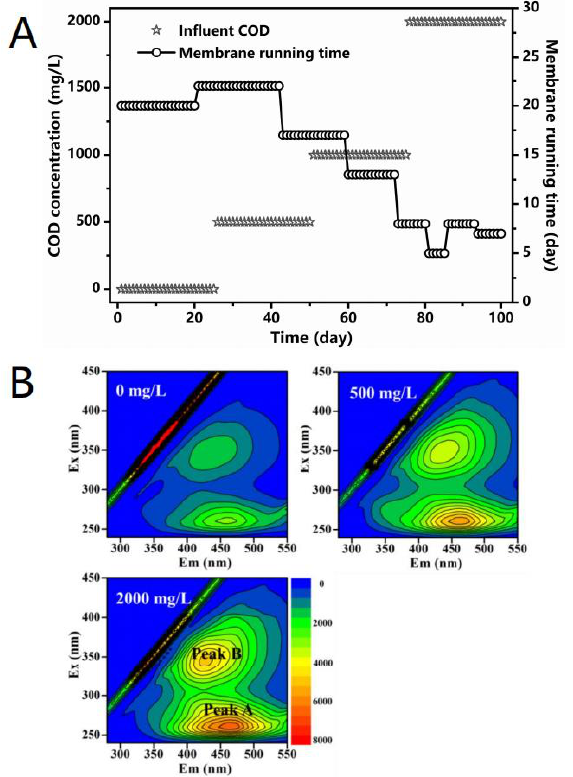
Figure 3. ( A ) Membrane fouling of the MBR during operation. ( B ) EEM spectra of SMP in the effluent of the MBR.